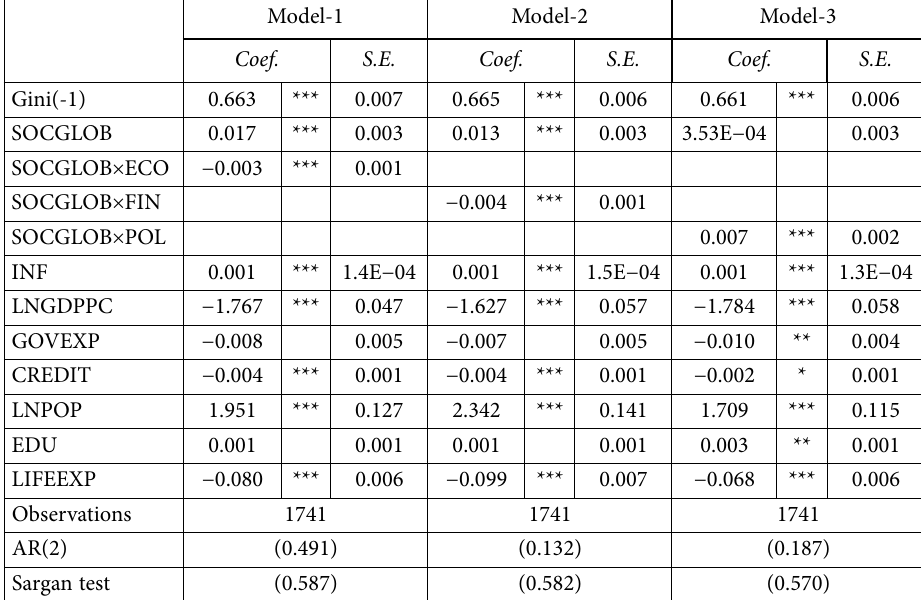
Table 4. The effects of social globalization under separate aspects of country